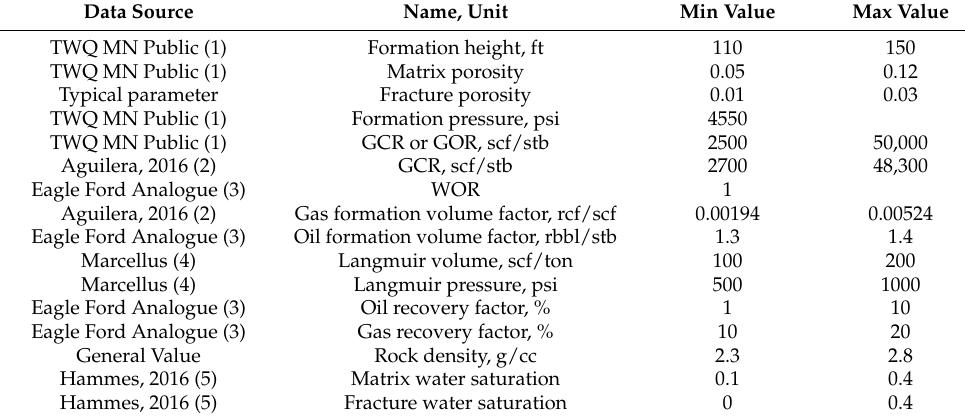
Table 2. Input parameters for resource